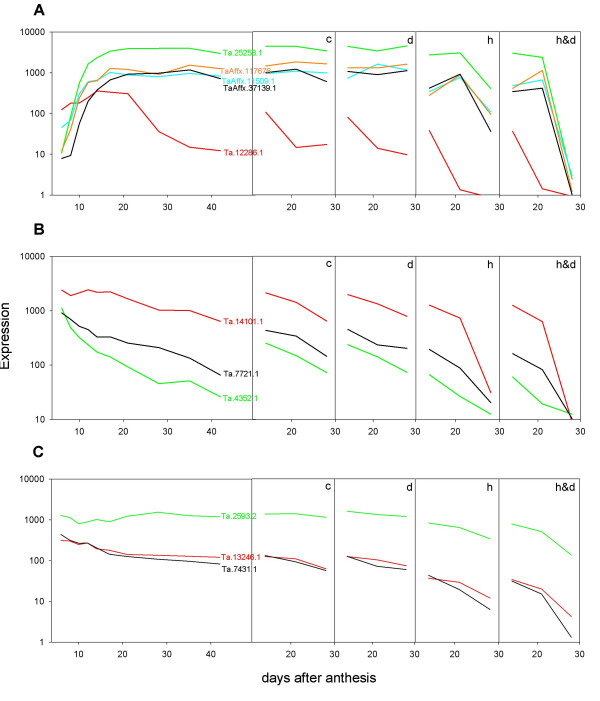
Expression profiles for probesets matching putative NAC (A), YABBY (B) and ARF (C) transcription factors.